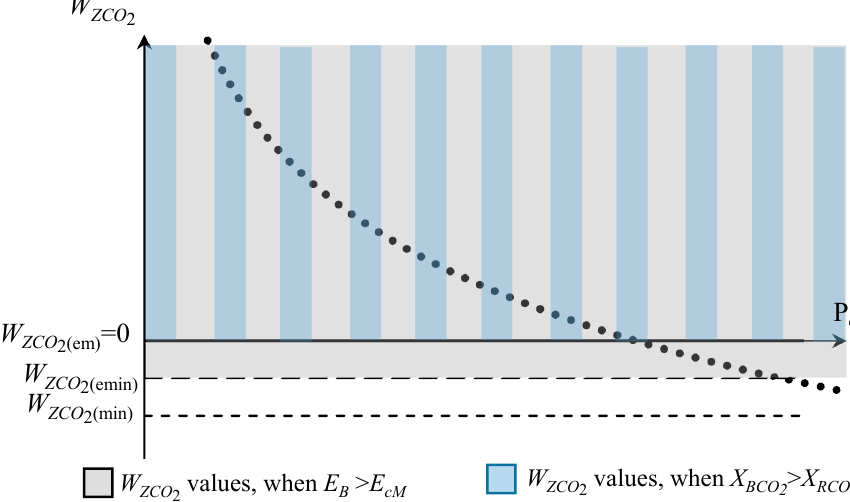
Figure 1. Graphic interpretation of the sustainable CO 2 emissions index.